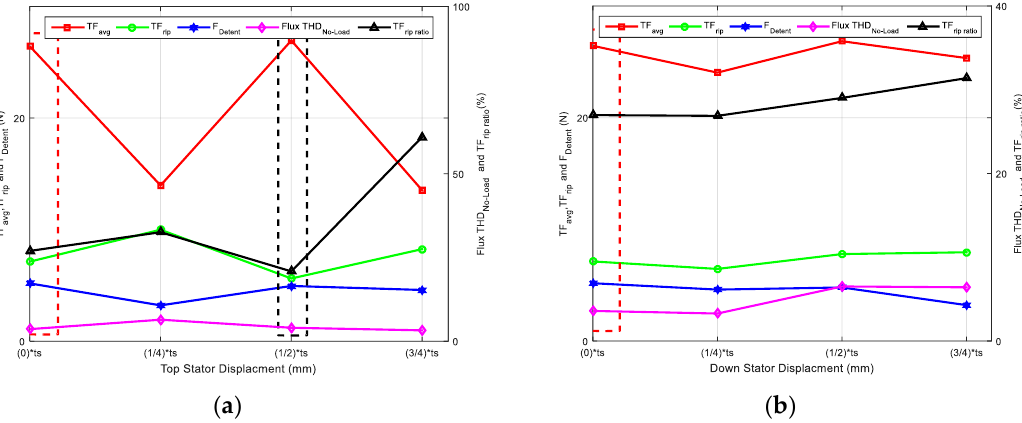
Figure 8. Stator tooth displacement results: ( a ) Comparison of displaced top stator tooth designs with DSLFSPMM-M1; ( b ) Comparison of displaced bottom stator tooth designs with DSLFSPMM-M1. Table 3. Modified parameters and performance comparison of DSLFSPMM-M1 with DSLFSPMM-M2. Parameter (Unit)